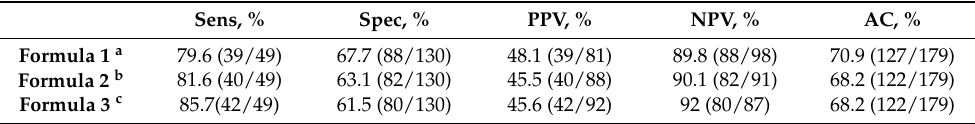
Table 3. Parallel combined diagnostic performance of PHHE-FOCUS signs for A-AAS. Sens, % Spec, % PPV, % NPV, % AC, % Formula 1 a